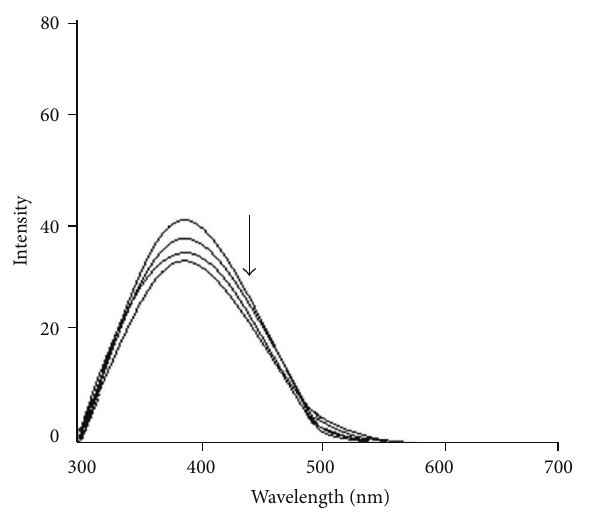
Figure4:FluorescencespectraofDNA-EB(10 mM),inthepresence of 0, 15, 25, and 35 mM of complex 1. Arrow shows the changes in the emission intensity as a function of complex concentration.